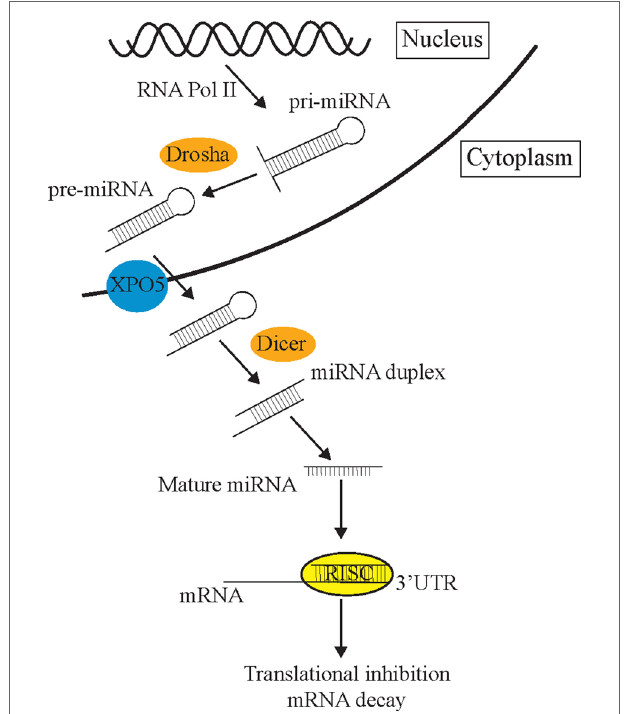
FiGURe 1 | The miRNA pathway . Primary miRNAs (pri-miRNAs) are transcribed from the genome and form hairpin structures. Nuclear-localized Drosha endonuclease cleaves pri-miRNAs into approximately 70 nt precursor miRNAs (pre-miRNAs) which are then transported from the nucleus to the cytoplasm by Exportin-5 (XPO5) via the nuclear pore complex, where they are further cleaved by Dicer into mature 21–23 nt miRNA fragments. Once the strands separate, the guide strand is loaded into the RISC complex (AGO and different cofactors) to scan the transcriptome for partial complementary target transcripts. These sequences are either repressed by the RISC complex or degraded in